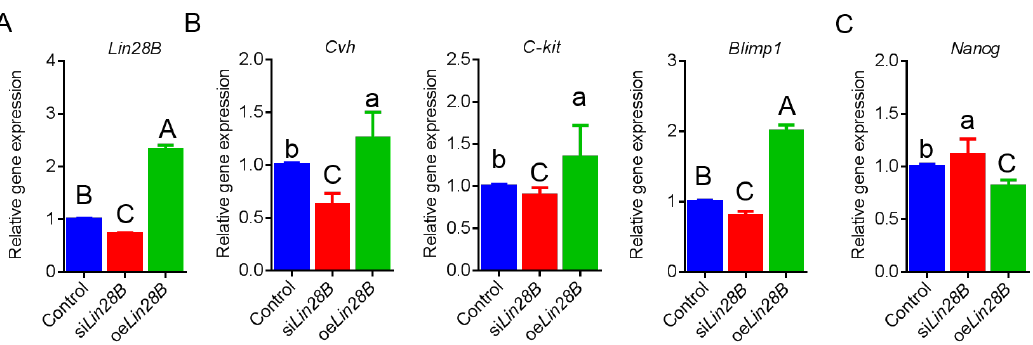
Figure 3. Lin28B overexpression/interference could promote/inhibit the formation of PGCs in vivo. ( A – C ) qRT-PCR was used to detect the expression of Lin28B, primary germ cells (PGCs) marker genes (Cvh, Ckit, and Blimp1), and totipotency marker gene ( NANOG ) in vivo. Different uppercase letters represent highly significant, different lowercase letters represent significant, and the same letters represent not significant.